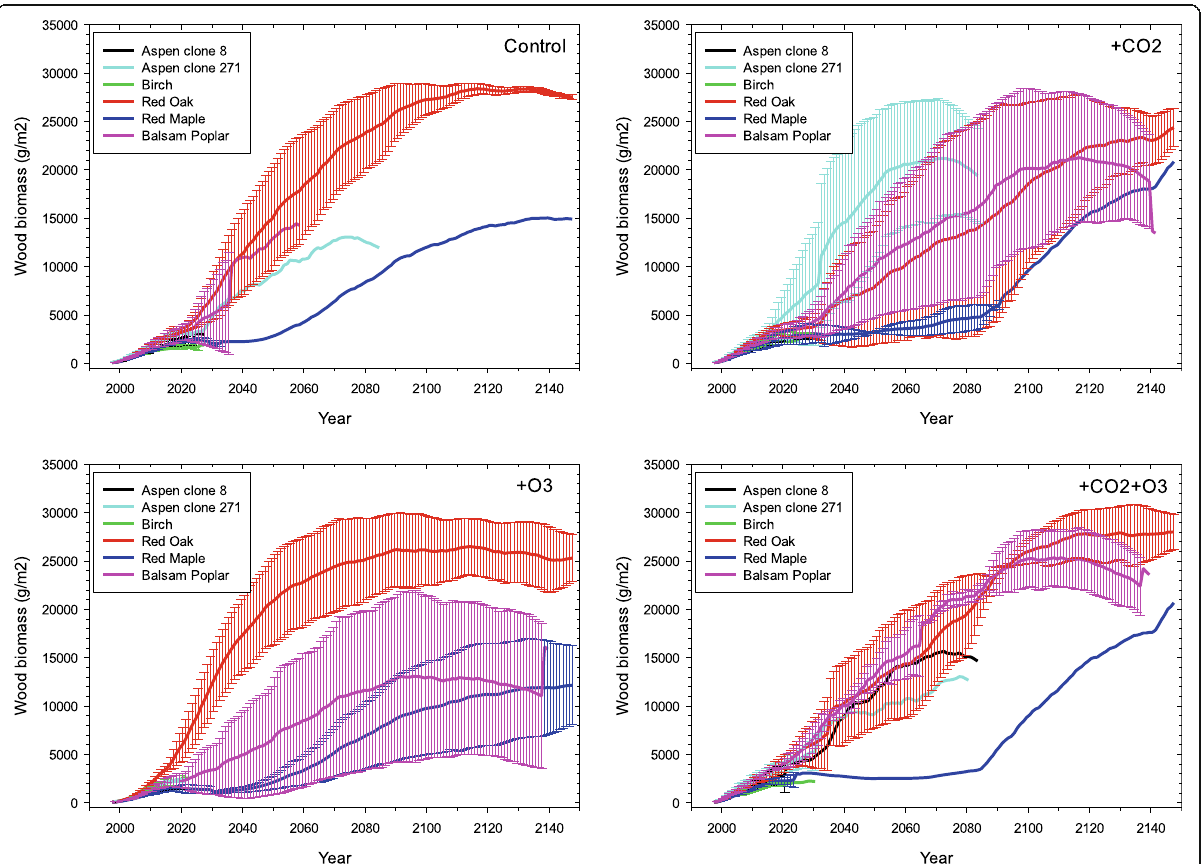
Fig. 9 Extrapolation by simulation 150 years into the future of an arbitrary assemblage of species found in northern Wisconsin under the treatments of the Aspen-FACE experiment. Error bars show one standard deviation of three replicates, and a taxon survived in only one replicate where there are no error